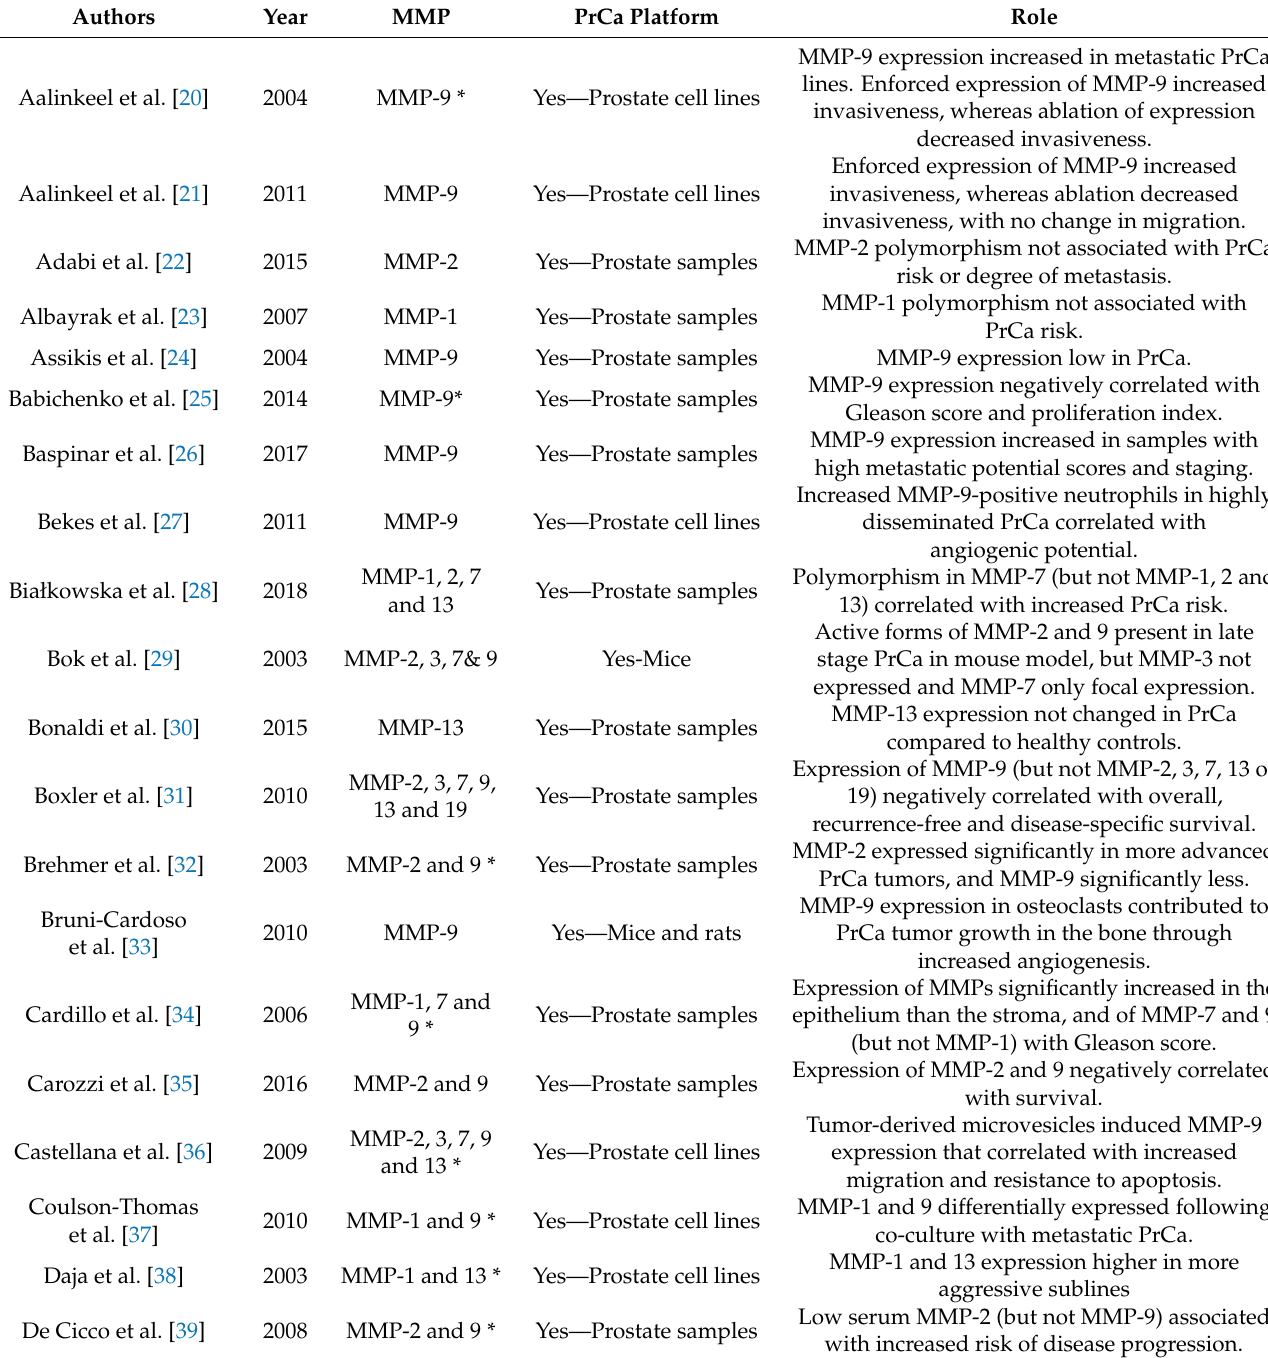
Table 1. Studies on soluble Matrix Metalloproteinases (MMPs) in prostate cancer